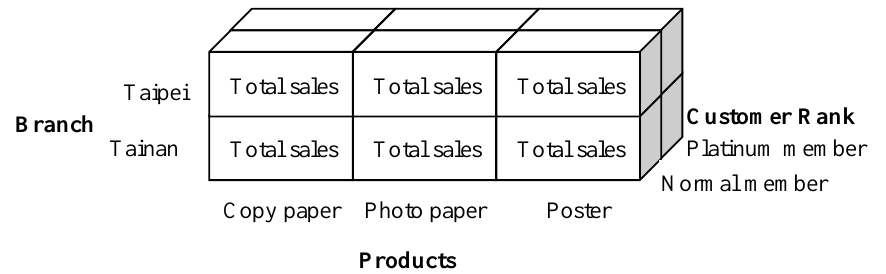
Figure 7. An example of a three-dimensional array in a multidimensional database.